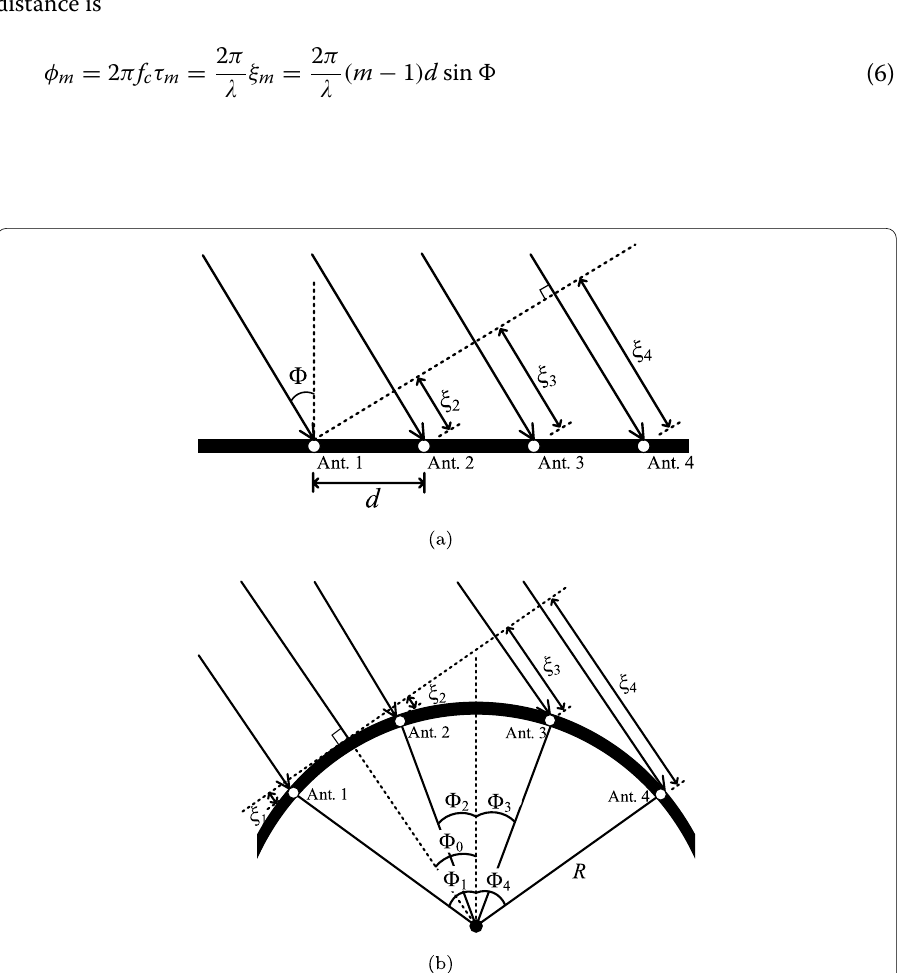
Fig. 3 Relative propagation distance for each antenna element: a ULA, b